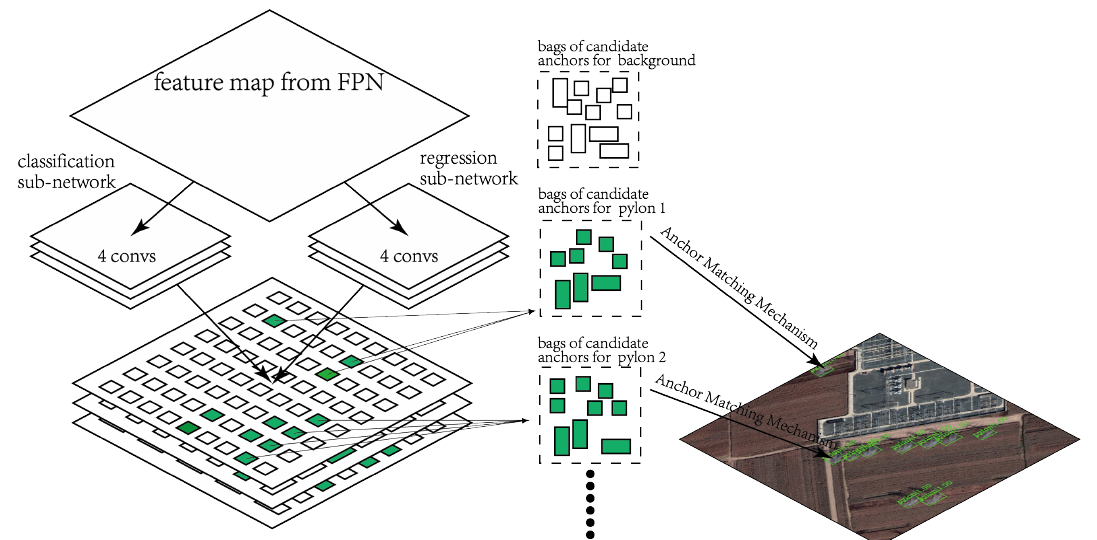
Figure 12. Structure of Retinanet FreeAnchor [40]. Retinanet FreeAnchor has the same input, classification, and regression sub-network as Retinanet [29]. The green-filled tetragons mean anchors containing objects, while the white-filled tetragons means anchors containing nothing. The tetragons put in the same bag of candidate contain the same object. The Anchor Matching Mechanism implements the learning-to-match approach.